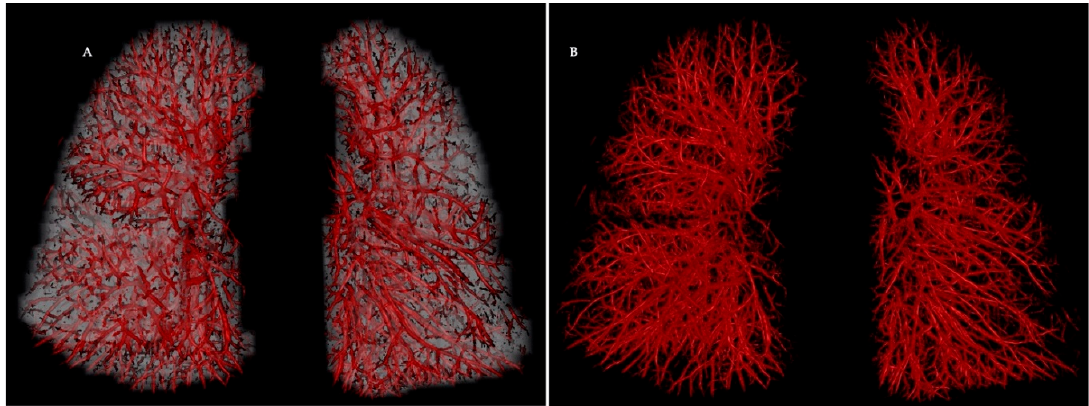
Figure 1. Representative computed tomography pulmonary angiography images in the coronal plane of a normal male subject with automated 3-D rendering of the intraparenchymal vasculature. The reconstruction with (panel A ) and without lung overlay (panel B ) demonstrates the ability of a good quality CTPA to depict subsegmental vessels. Volumetric reconstructions can be color-coded based on vessel radii and automated vessel segmentation can be used to create a blood volume distribution profile by measuring the vascular cross-sectional area in regions of interest. Image courtesy of Dr Wei